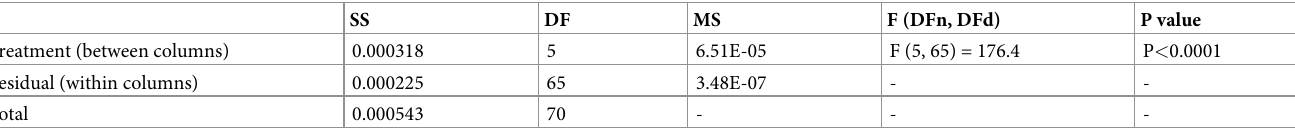
Table 4. ANOVA test results of the proposed CNN-LSTM, CNN, and LSTM algorithms. SS DF MS F (DFn, DFd) P value Treatment (between columns) 0.000318 5 6.51E-05 Residual (within